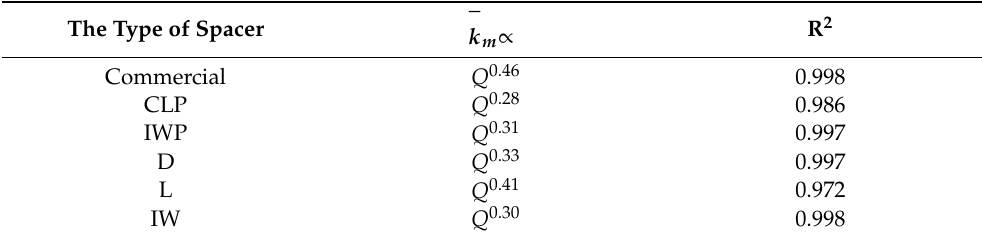
Figure 12. Cell-average mass transfer coefficient k m in a length of five-unit cells as a function of flow rate in commercial spacer-filled channel and a length of four-unit cells as a function of flow rate in TPMS-based spacer-filled channel. Table 4. The power–law correlation between k m and Q in all spacer-filled